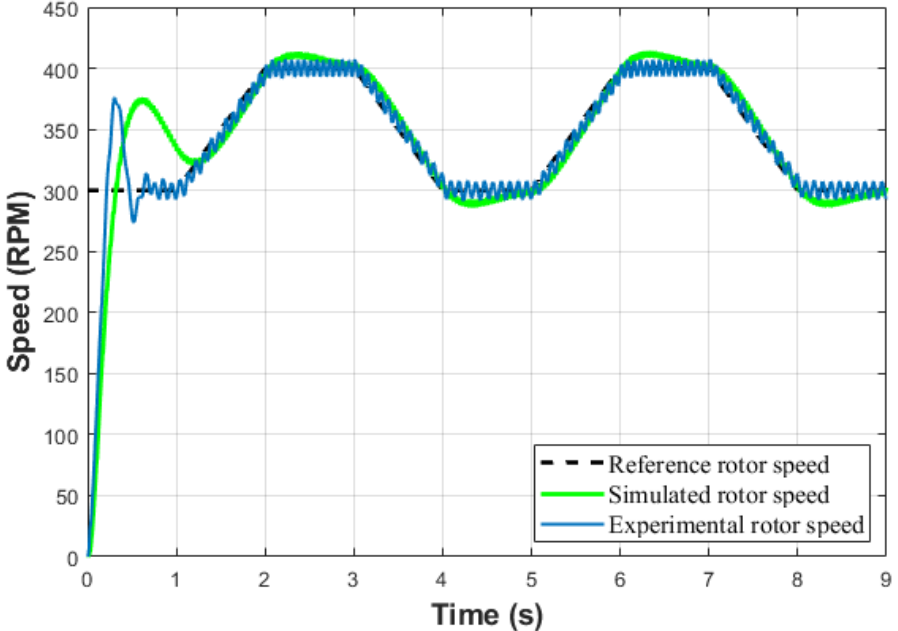
Figure 22. Behavior of the speed control loop with trapezoidal reference.